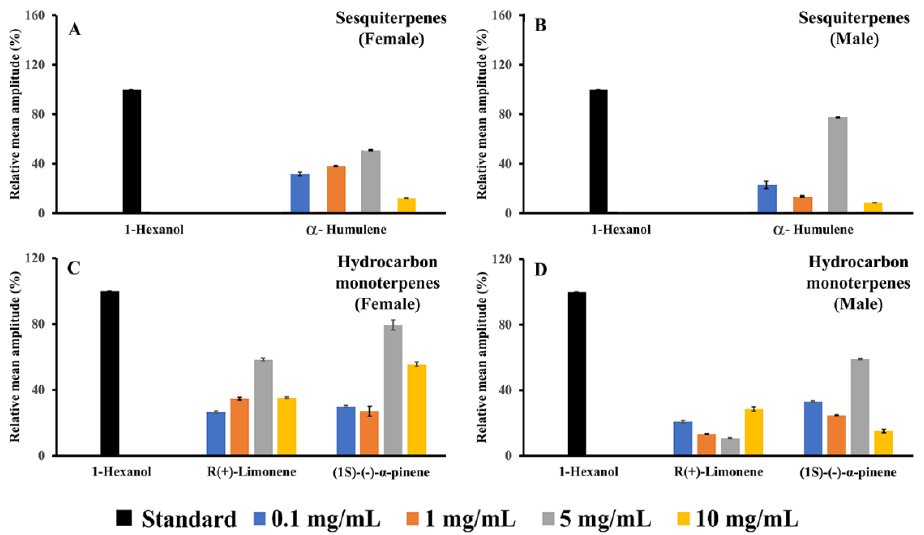
Figure 5. Mean normalized electroantennography (EAG) responses for sesquiterpenes ( A , B ) and hydrocarbon monoterpenes ( C , D ) compounds in female and male Aulacophora foveicollis to plant volatiles at 0.1, 1, 5.0 and 10 mg/mL concentration.